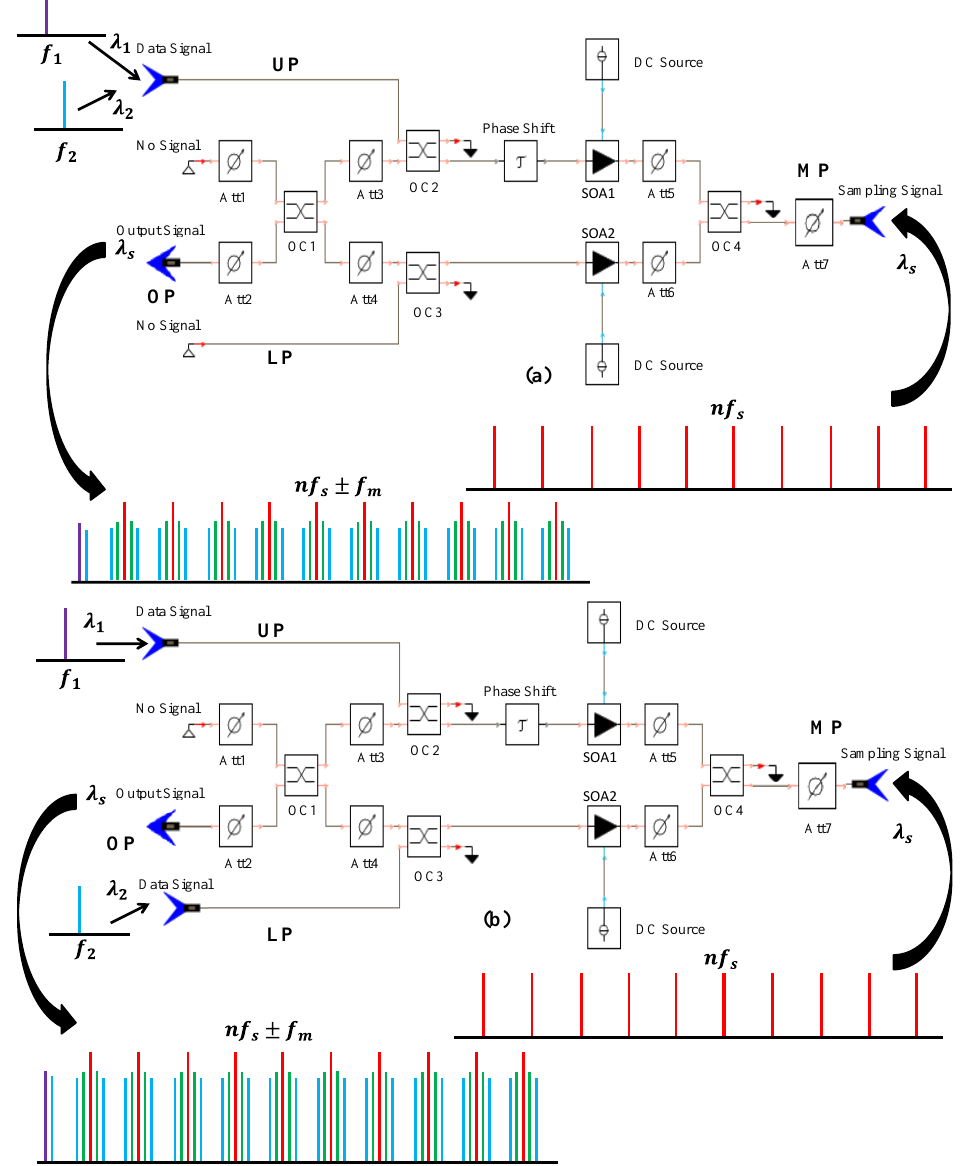
Figure 2. SOA-MZI in the counter-direction configuration. ( a ) Standard modulation mode, ( b ) Differential modulation mode.